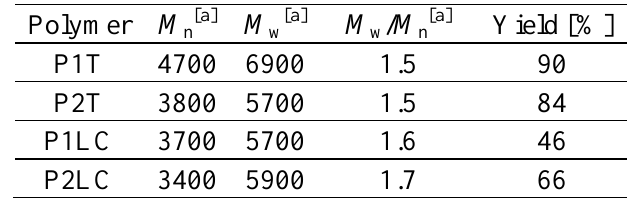
Table 1. Polymerization